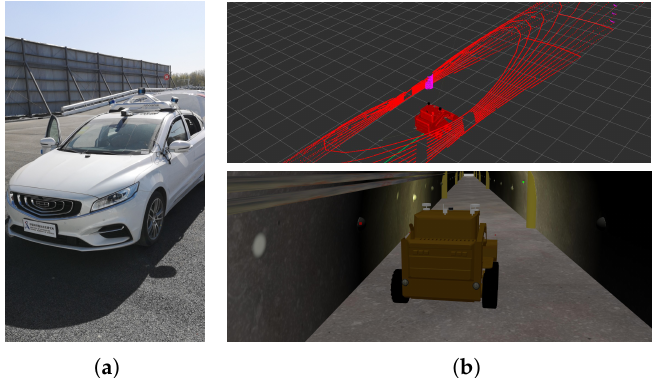
Figure 7. Dataset sampling platform. ( a ) Autonomous driving car; ( b ) Simulated mine car and scan example. Magenta lazer points are reflected from brown signs in the simulated